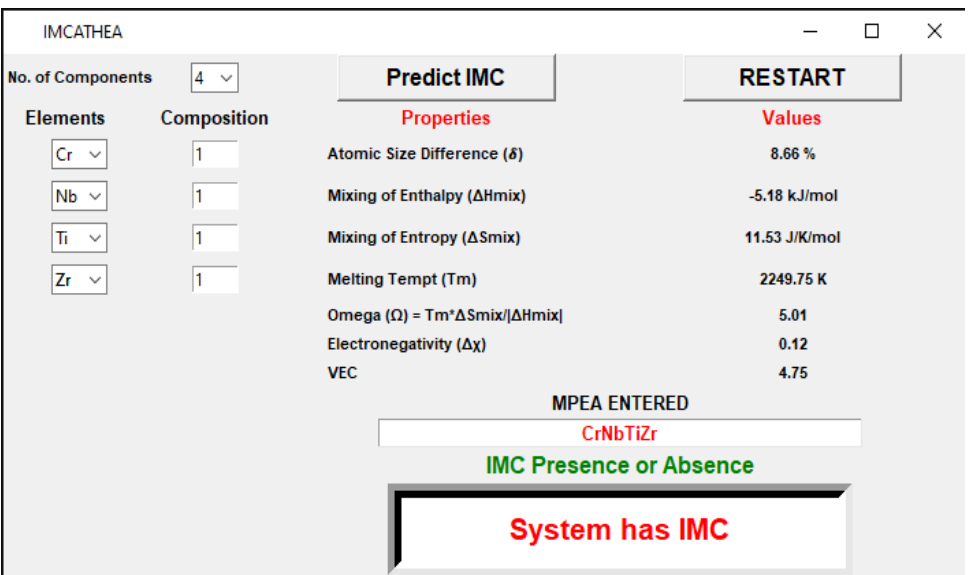
Figure 5. The layout design of IMCATHEA GUI